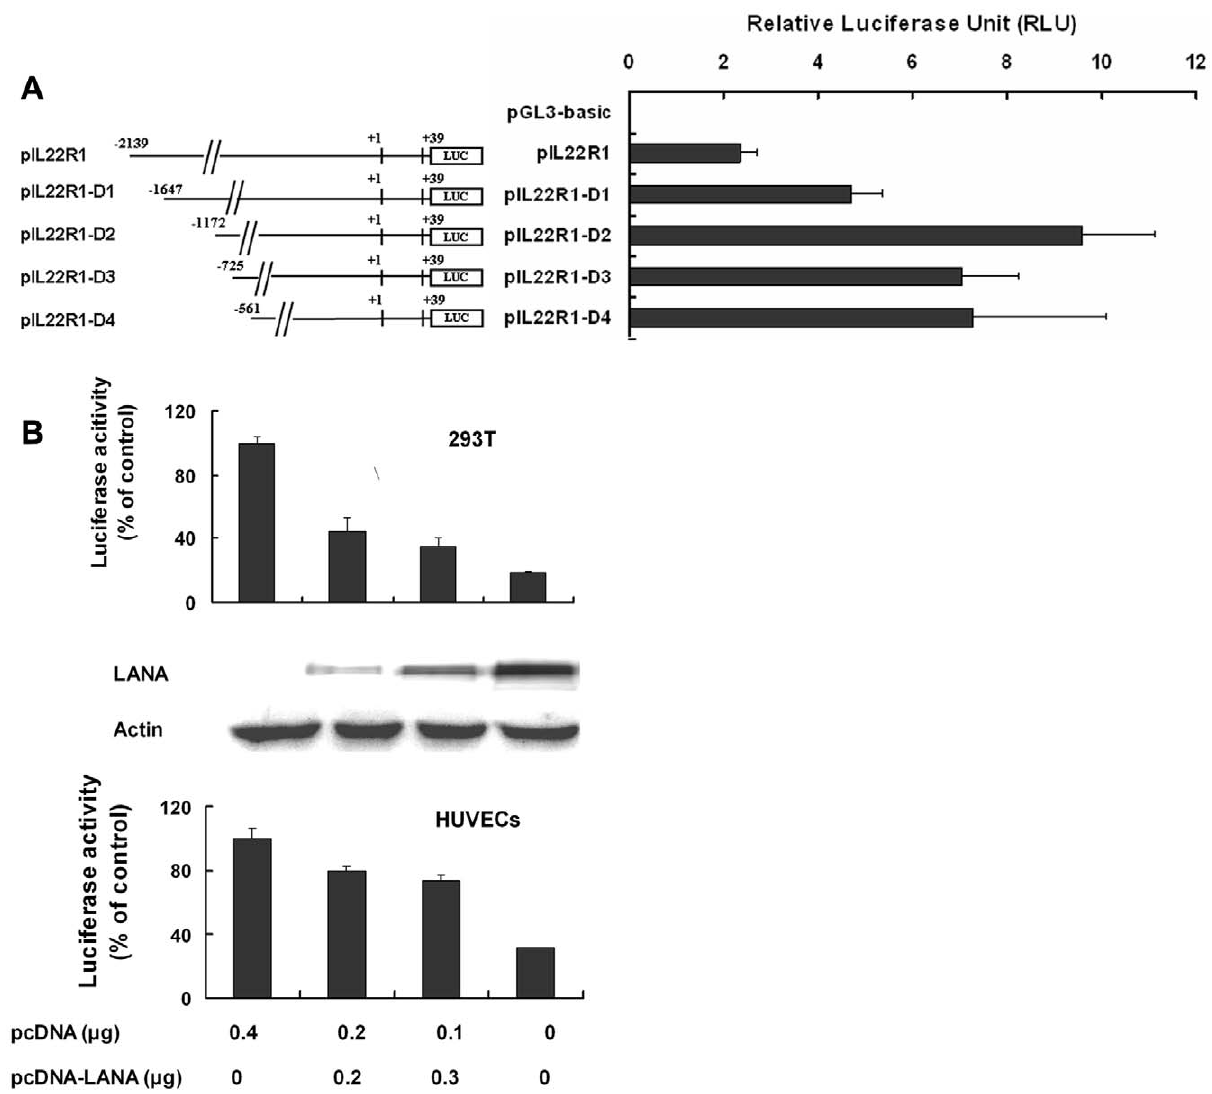
Figure 2. LANA down-regulates IL-22R1 promoter activity in a dose-dependent manner. ( A ) Schematic of pIL22R1 ( 2 2139 to + 39) and a series of deletion mutants (pIL22R1-D1, D2, D3, and D4). ( B ) LANA down-regulates IL-22R1 promoter ( 2 2139 to + 39) activity. pIL22R1 ( 2 2139 to + 39) was co-transfected with increasing amounts (0, 0.1, 0.2 or 0.4 m g) of LANA into 293T cells. At 48 h post-transfection, cells were lysed and assayed for luciferase activity. The expression levels of LANA were detected in cell lysates by western blotting using anti-LANA-C antibody (top panel). The regulation of the IL-22R1 promoter ( 2 2139 to + 39) by LANA was also analyzed in HUVEC cells (lower panel).